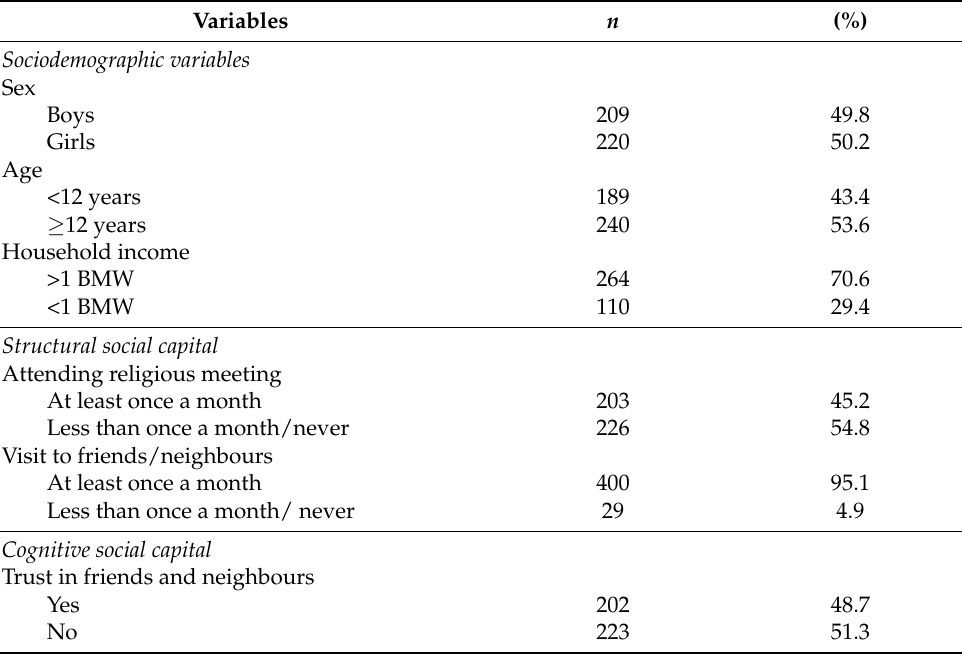
Table 1. Demographic, socioeconomic, clinic, and social capital characteristics of the sample.